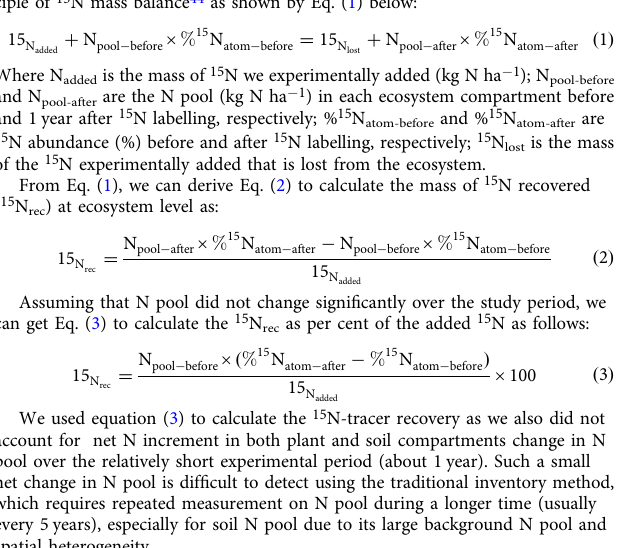
x and NO y inputs